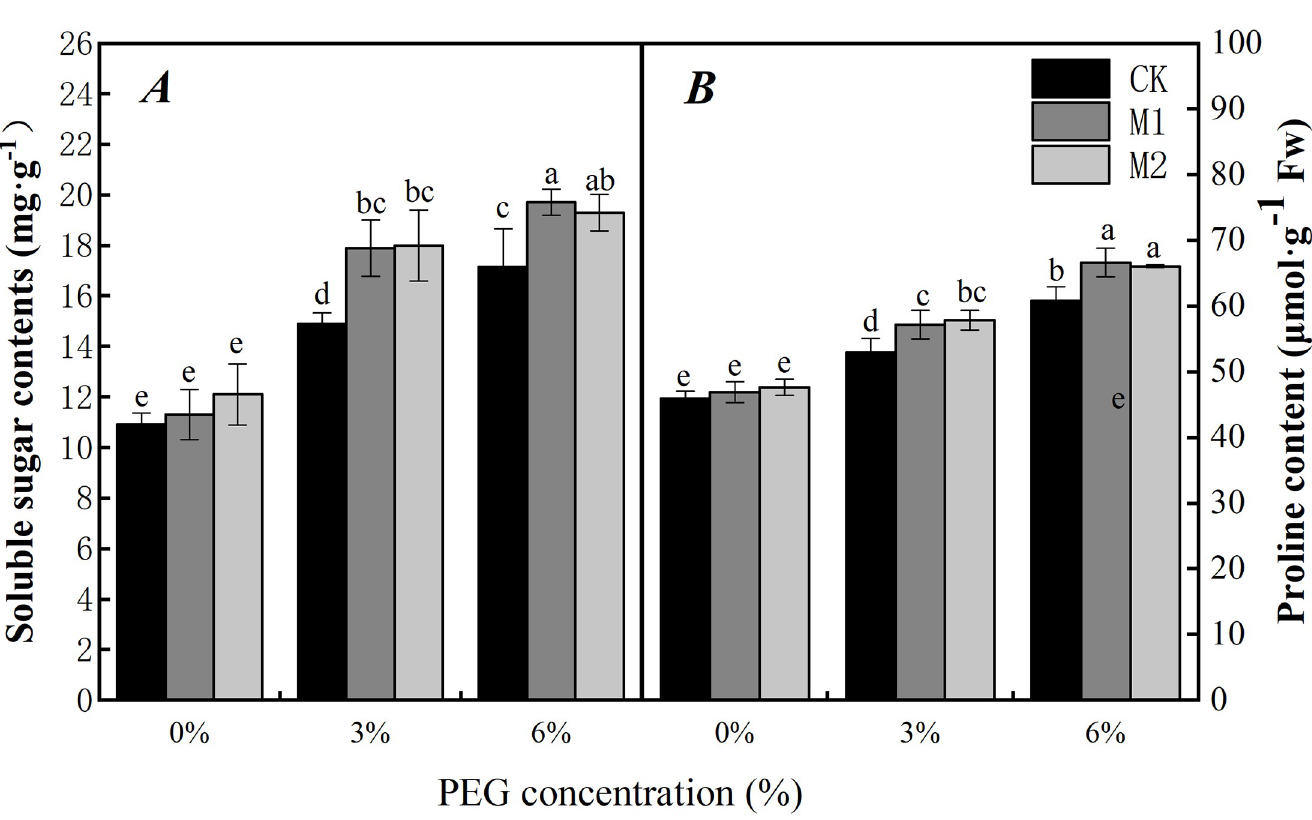
Fig 8. Effect of soaking with melatonin on soluble protein (A) and proline (B) of soybean radicle under PEG stress. 0%, 3% and 6% were indicated 0%, 3% and 6% PEG6000 ( w/v ). Values are the means of three replicates ± S.E. Bars with different letters are significantly different at P � 0.05.